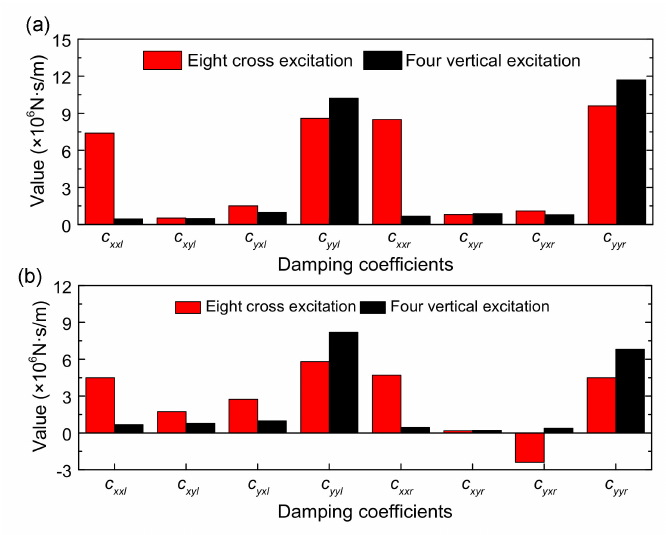
Figure 11. Bearing damping coefficients under two excitation methods: ( a ) 50 r/min; ( b ) 225